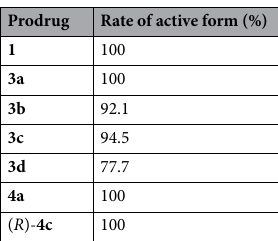
Table 3. Metabolic rate of cyclofenil analogs.